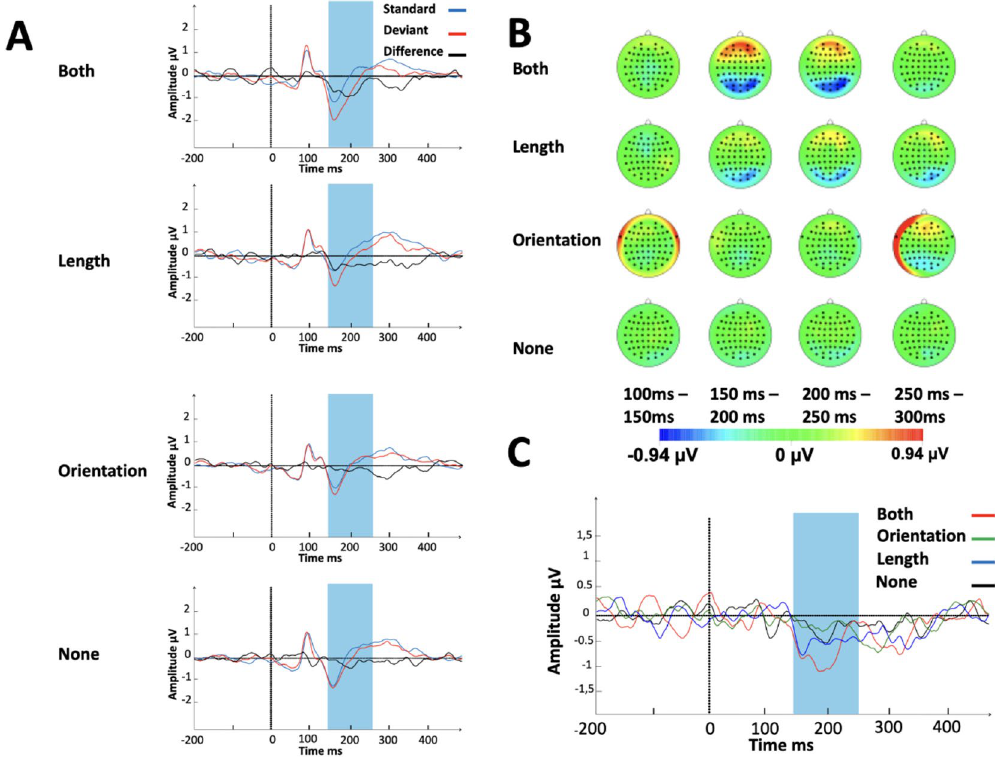
Figure 2. Electrophysiological results of the experiment: ( A ) grand average waveforms with difference waves in posterior electrode sites in each of the segmentability conditions. ( B ) The scalp distribution of the event-related potential in different segmentability conditions split by temporal windows. ( C ) Grand averages of the difference waves as a function of the stimulus condition. Created using: BrainVision Analyzer, Brain Products GmbH, Gilching,